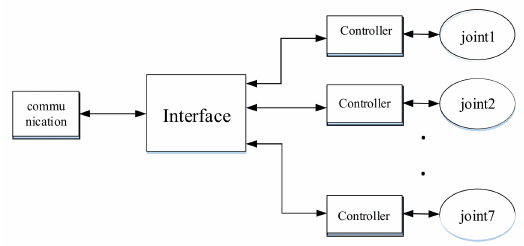
Figure 9. System of PID single-joint control.